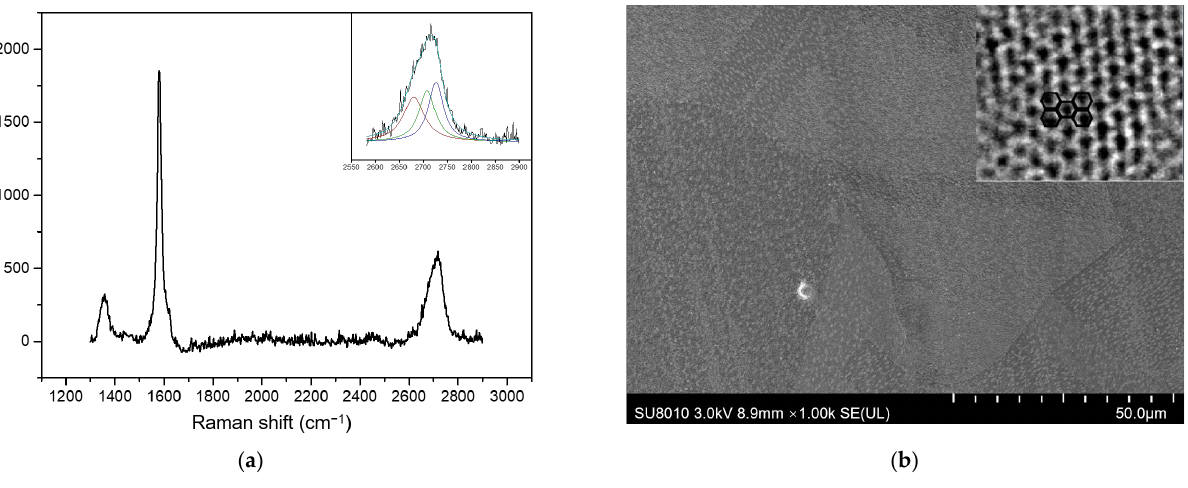
Figure 8. Characterization of graphene grown from coal tar at 500 ◦ C: ( a ) Raman spectrum of graphene grown by coal tar at 500 ◦ C (the upper right corner is the result of the fit of the Lorentz splitting of the 2D peak in the spectrum); ( b ) SEM of graphene grown by coal tar at 500 ◦ C (the upper right corner is Graphene lattice image under spherical aberration microscope).